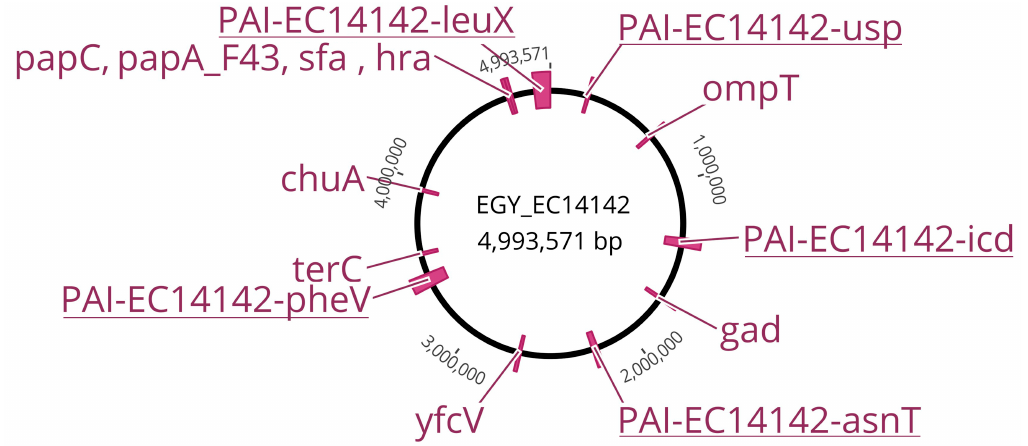
Figure 1. Comprehensive genetic map of the chromosome EGY_EC14142 belonging to the UPEC isolate EC14142. The map is based on the chromosome of E. coli K-12 MG1655 (NC_000913.3). PAIs and virulence factors encoding genes are indicated in accordance with their position on